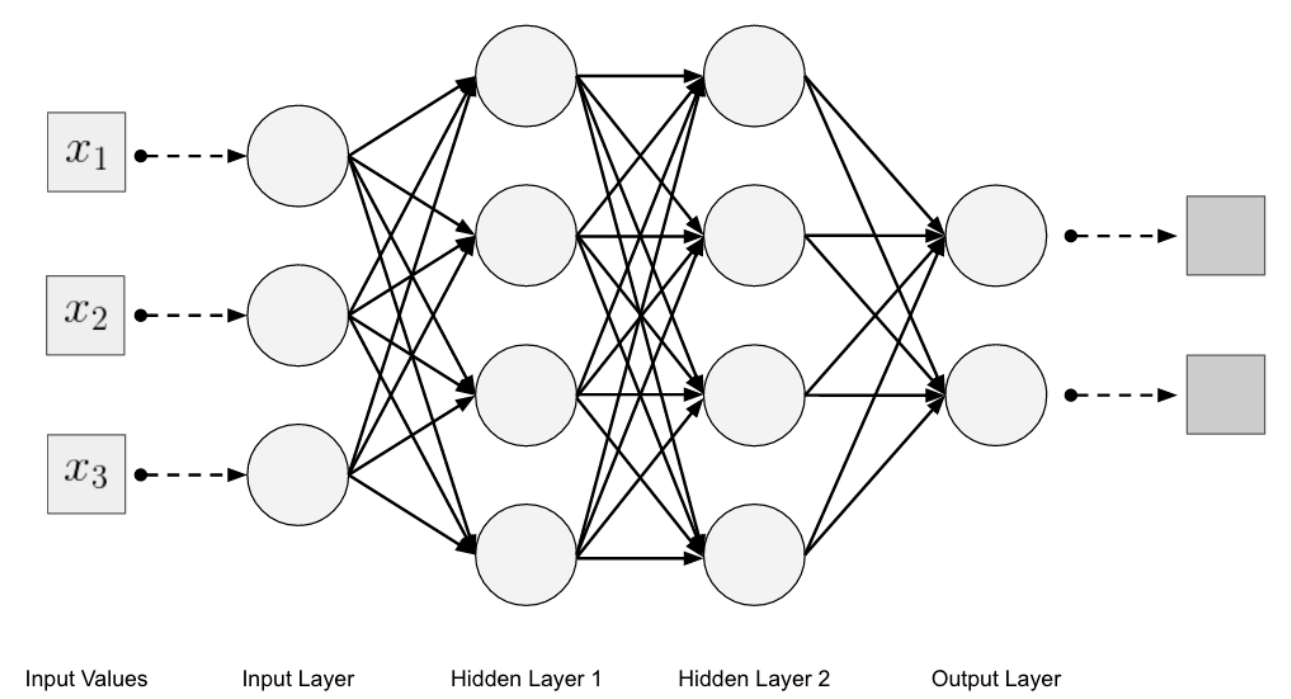
Figure 2. A multilayer network with two hidden layers [22].